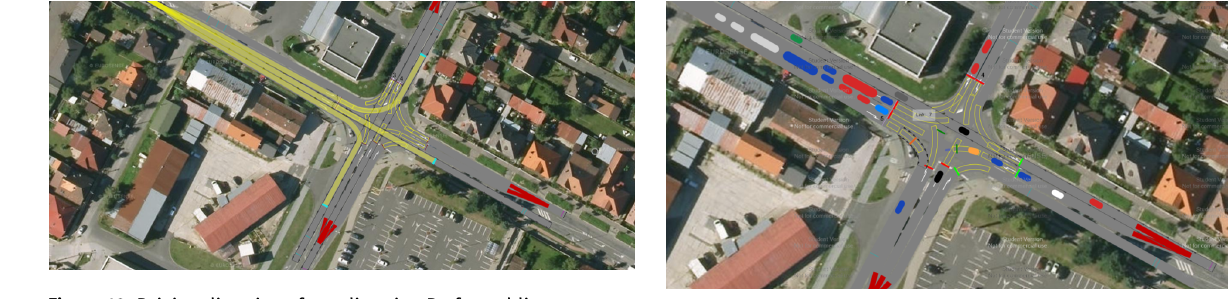
Figure 13: Traflc situation at the 2nd modified intersection model